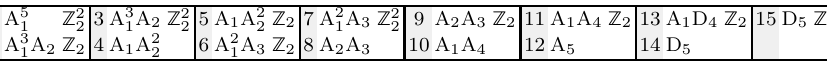
Table 7 . Algebras of maximal rank for the heterotic Z 4 triple.